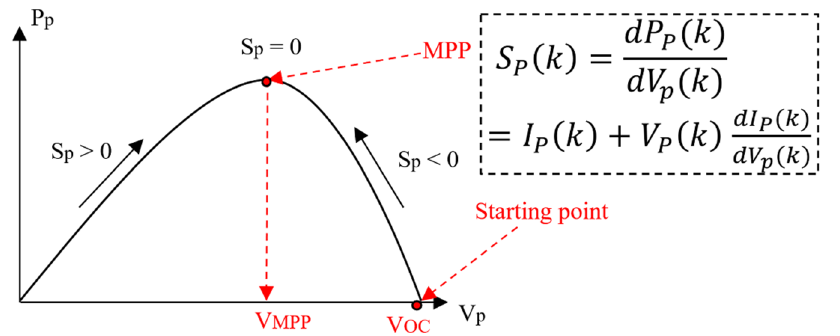
Figure 6. INC-MPPT algorithm with fuzzy logic.